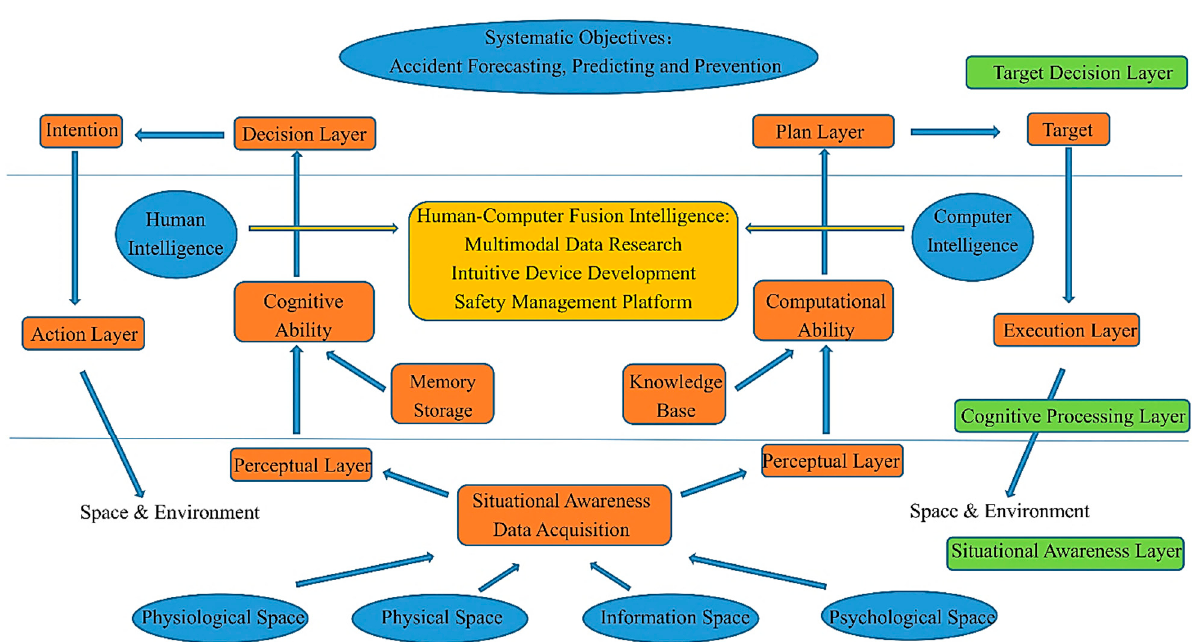
Figure 10. Hazard recognition based on human–computer fusion intelligence.